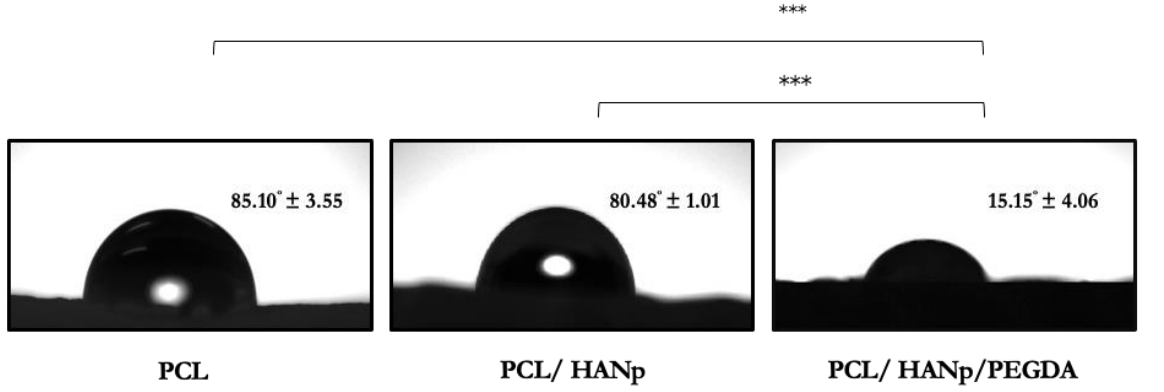
and is shown in Figure 4.